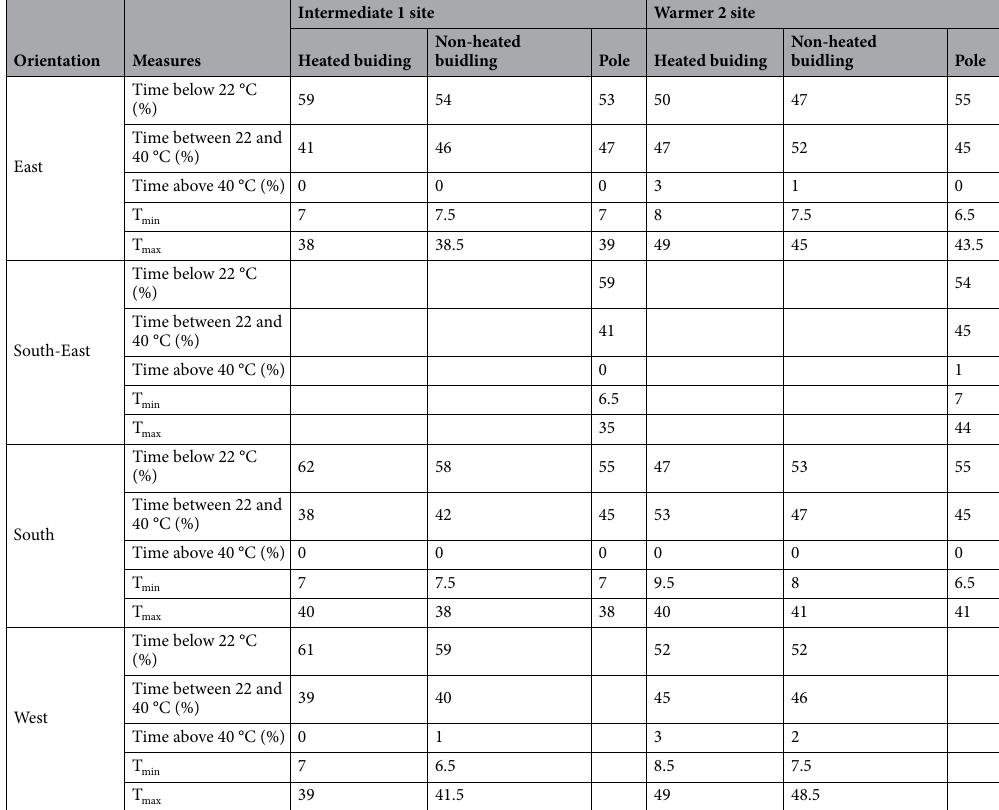
Table 1. Percentage of time below, between, and above the extended optimal temperature range of 22 − 40 °C, and minimal and maximal temperature inside and outside of Classic bat boxes from mid-May to mid-September 2017 at intermediate and warmer sites in Quebec, Canada presented per mountings and orientations.